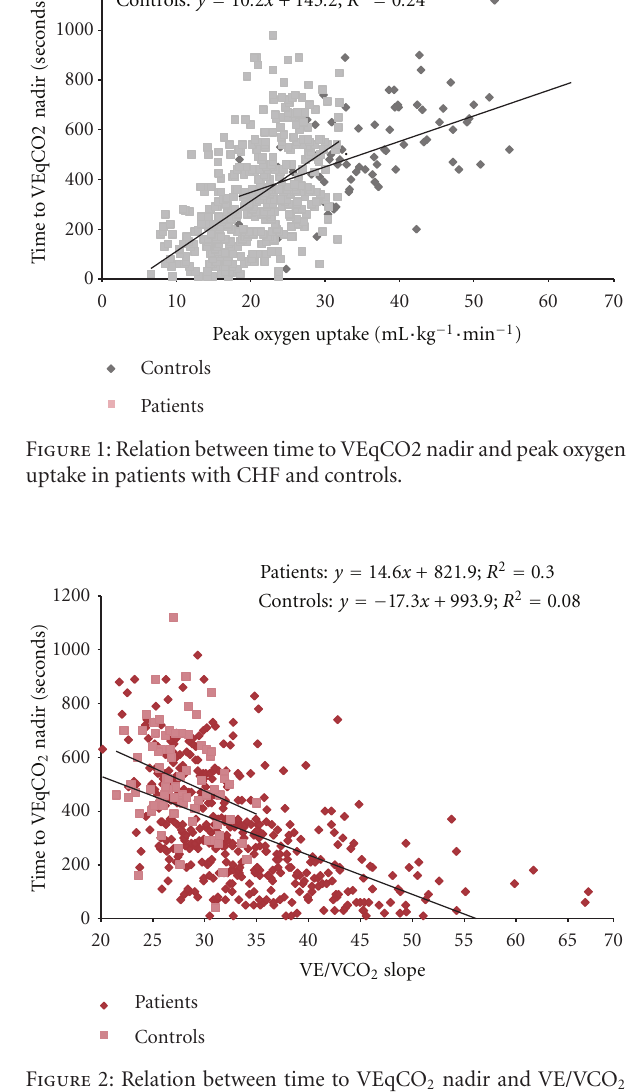
ROC curve analysis of the relation between time to VEqCO 2 nadir (and both VEqCO 2 nadir and peak VO 2 ) and all-cause mortality at 12 months is shown in Figure